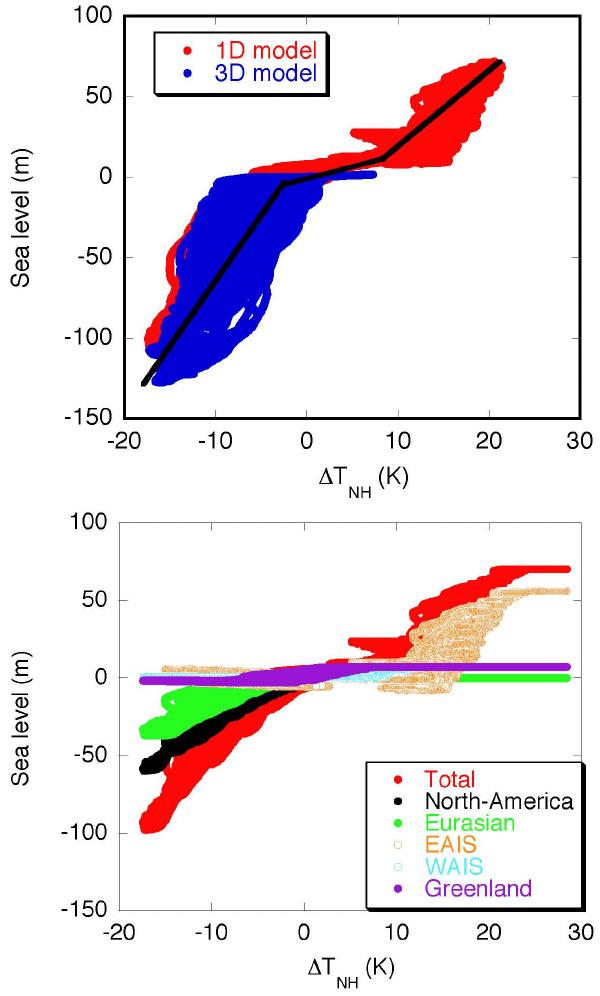
Fig. 2. (a) Sea level change is shown as a function of the recon- structed temperature for a set of 3-D NH ice sheets (blue) and for a set of five 1-D ice-sheet models (red) (Bintanja and Van de Wal, 2008; De Boer et al., 2010). The more sophisticated 3-D results are validated by observation of sea level (Lambeck and Chapell, 2001; Rohling et al., 2009). The 1-D results are in line for the colder climate condition with the 3-D results. The warm temperatures in combination with the sea level change resemble the melt of SH ice. The thick lines show the mean trends, emphasizing the low gradient for the present-day climate centred around zero. (b) The response of the individual ice sheets. Note the strong transient and nonlinear response for each ice